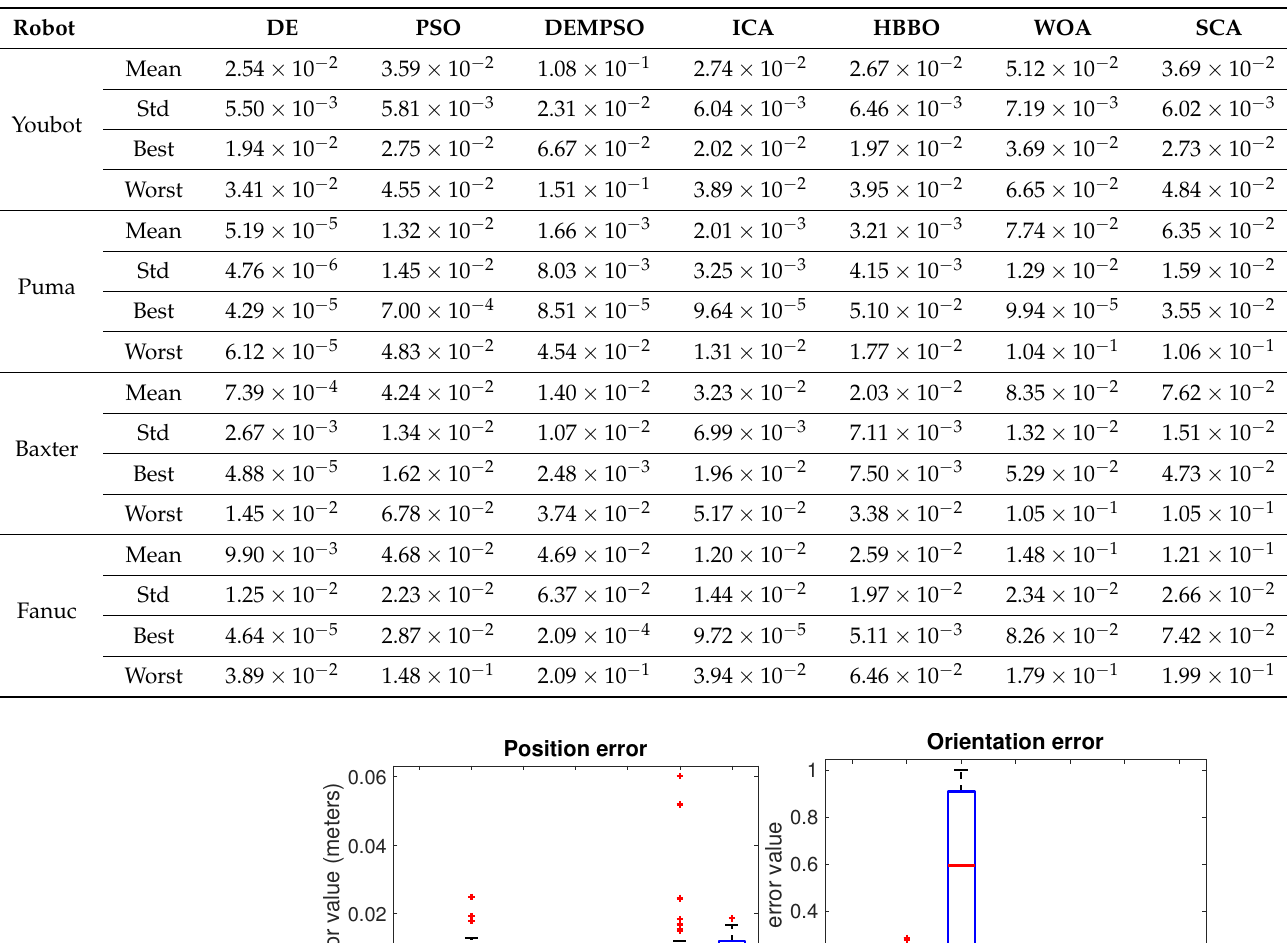
Table 7. Objective function comparative results for circle path.